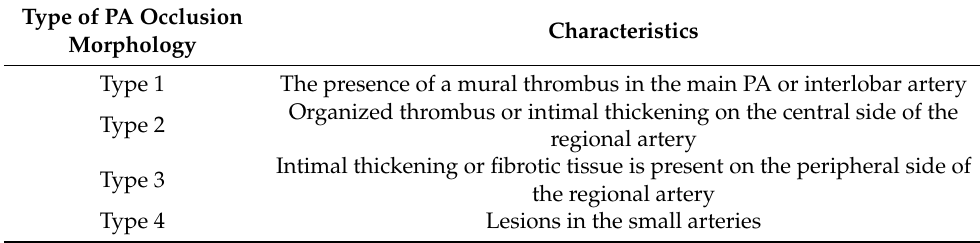
Table 3. PA occlusion morphology (Jamieson disease classification).